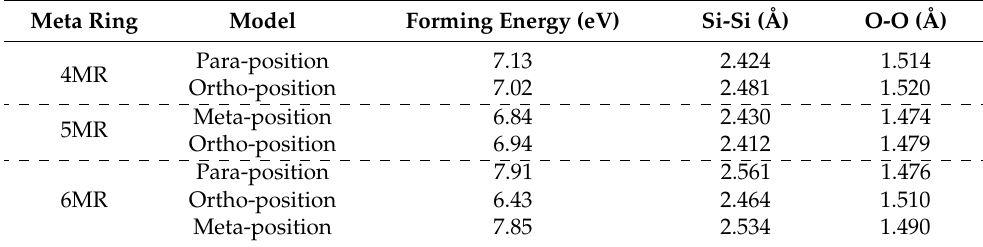
Table 2. Formation energy and structure of ODC(I) defects and POL defects added in different ring positions and bond length of silicon-silicon bond and oxygen-oxygen bond after structural optimization. Meta